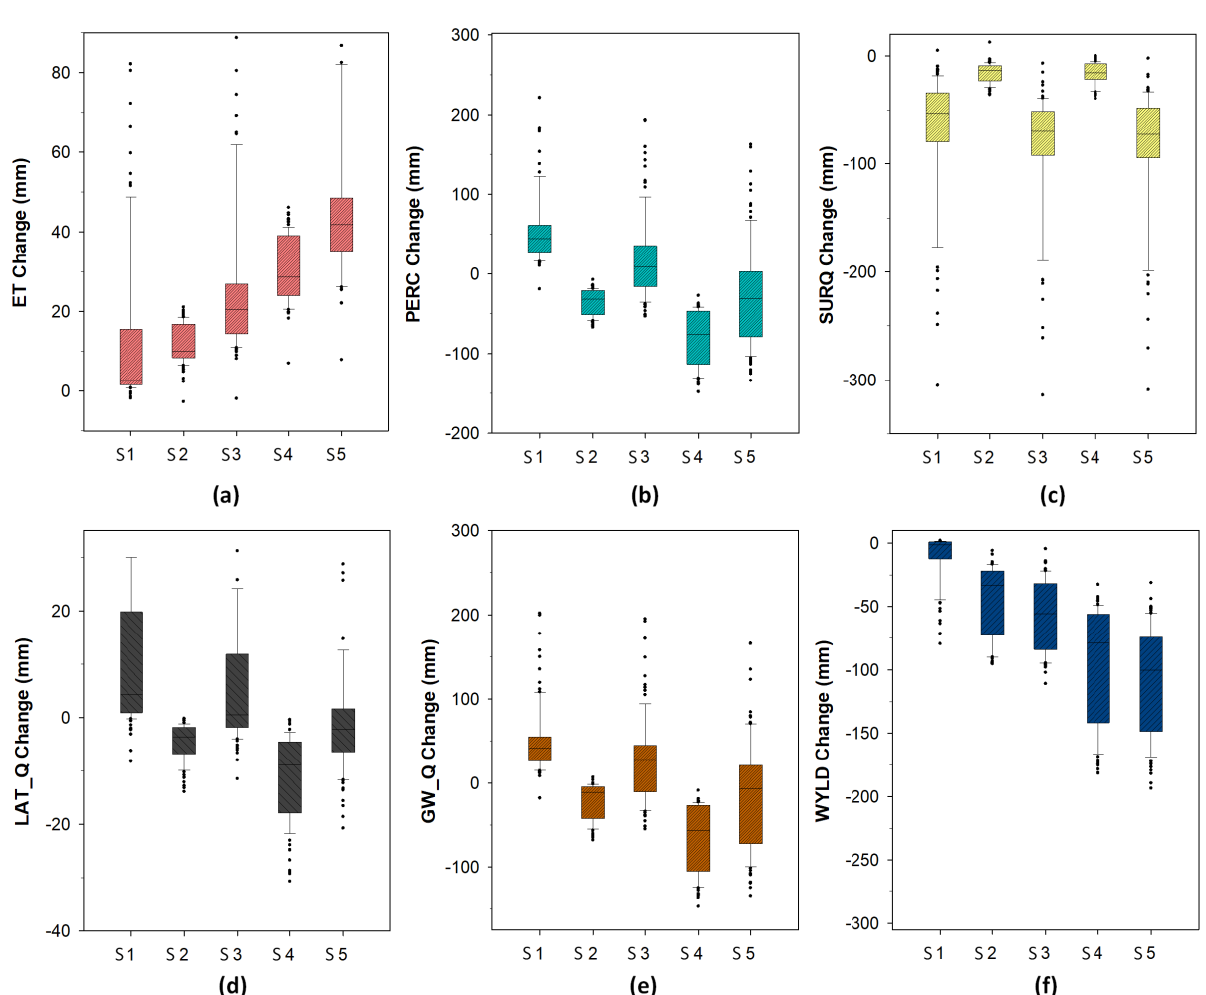
Figure 6. Individual and combined effects of land use/cover change and climate change at Quino watershed on the ET ( a ), PERC( b ), SURQ ( c ), LAT_Q ( d ), GW_Q ( e ) and WYLD ( f ). (Horizontal scale: S1: LU2051_Historical; S2: LU2011_Immediate Future; S3: LU2051_Immediate Future; S4: LU2011_Intermediate Future; S5: LU2051_Intermediate Future)